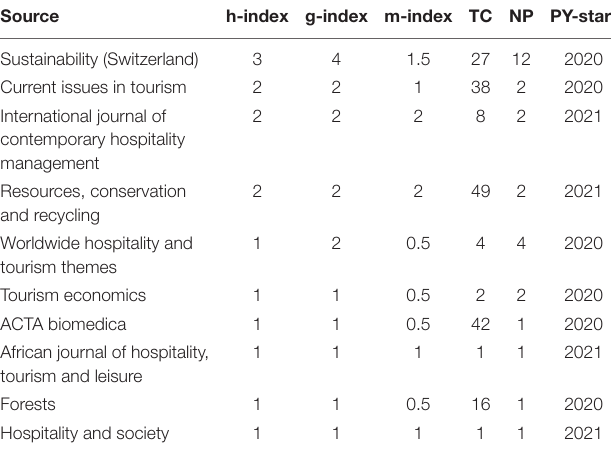
TABLE 3 | Top 10 journals with source impact.